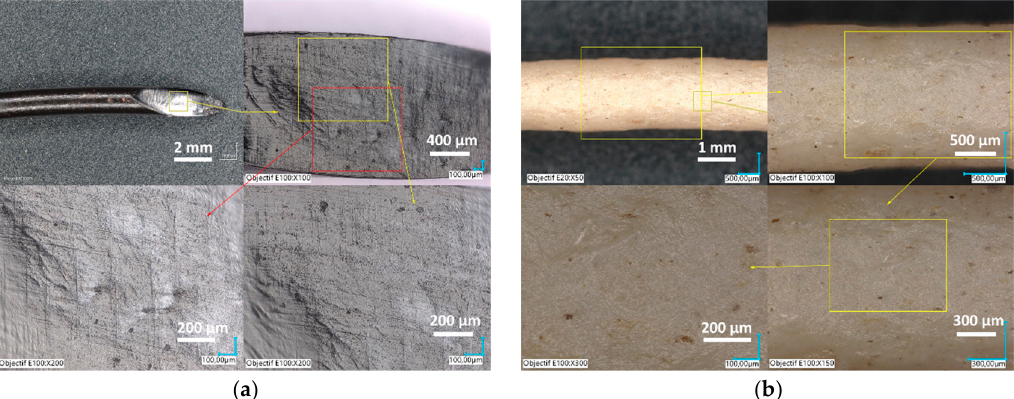
Figure 7. Surface state of the as-received filaments observed by digital microscopy: ( a ) PLA and ( b ) PF.